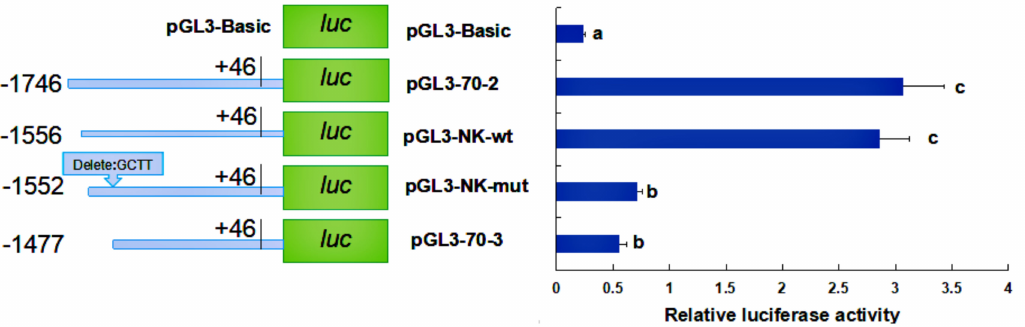
Figure 10. Activity analysis of the site-deleted mutation plasmid pGL3-NK-mut. The distance between pGL3-70-2 and pGL3-70-3 contains a sole NF- κ B binding site in the promoter of HdHSP70 . In addition, the binding sites of the transcription factor NF- κ B is GCTTAAGAGGAATTT, and the recombinant plasmid was named pGL3-NK-wt. When GCTT was deleted, the new sequence became AAGAGGAATTT, and the mutant recombinant plasmid was named pGL3-NK-mut. The pGL3-Basic plasmid was served as a negative control. Values are means ± SD of biological replicates ( n = 3). The different letters on the error bars represent significant differences, p <0.05. Luc: luciferase expression